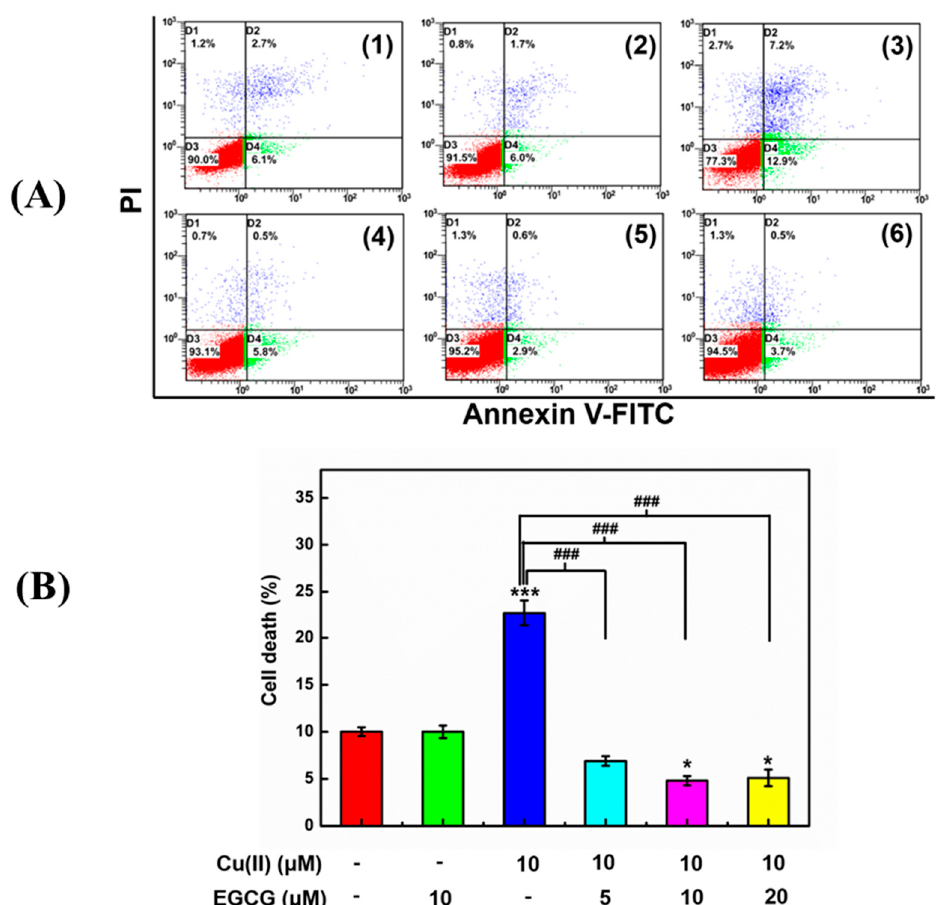
Figure 8. EGCG effect on the cells activity against Cu(II)-induced cytotoxicity in the transduced PC12 cells. ( A ) FACS analysis of the cells treated without ( 1 ) (control) and with 10 µ M EGCG ( 2 ), 10 µ M Cu(II) ( 3 ), the mixture of 10 µ M Cu(II) with 5 ( 4 ), 10 ( 5 ), and 20 ( 6 ) µ M EGCG for 48 h, respectively. ( B ) The cell apoptotic percentage in D2 and D4 phase together with FACS determined by PI and Annexin V-FITC fluorescence intensity upon various indicated treatments. Error bars = SD, n = 3; *: p < 0.05, ***: p < 0.001 vs. control group; ###: p < 0.001 vs. [Cu(II)] = 10 µ M.